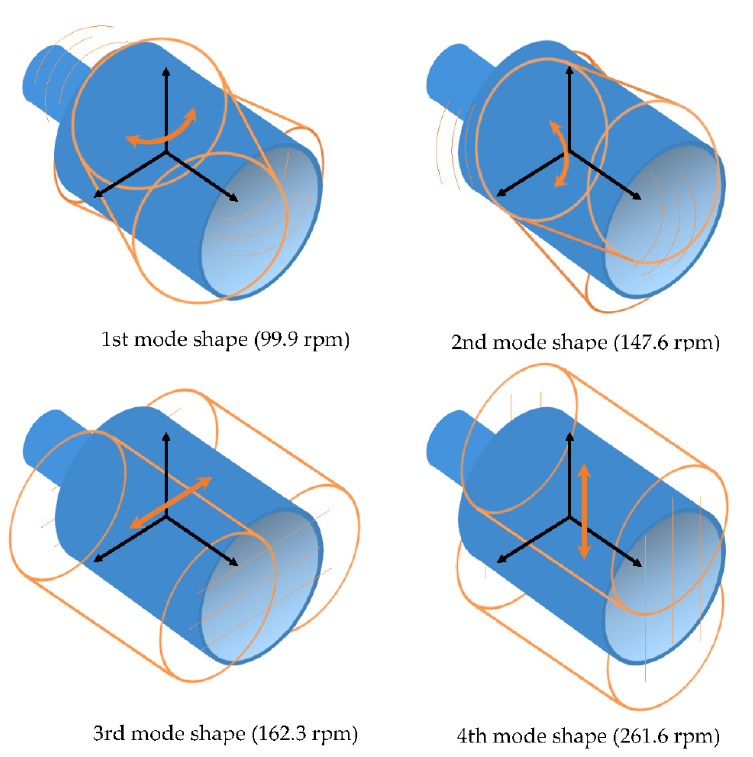
Figure 8. Lowest four resonance mode shapes of the front-loading type washing machine model.